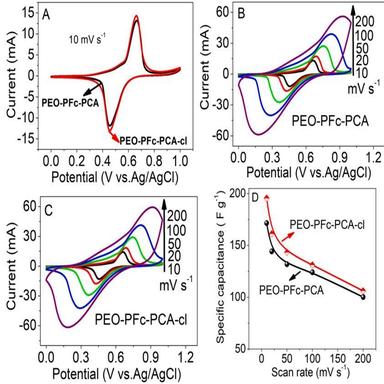
(A) Cyclic voltammetry comparison curves of PEO-PFc-PCA before and after photo-crosslinking at a scan rate of 10 mV s -1; (B) and (C) show the cyclic voltammetry curves of PEO-PFc-PCA before and after photo-crosslinking at different scan rates; (D) Comparison of the specific capacitance of PEO-PFc-PCA before and after photo-crosslinking as a function of scan rate.